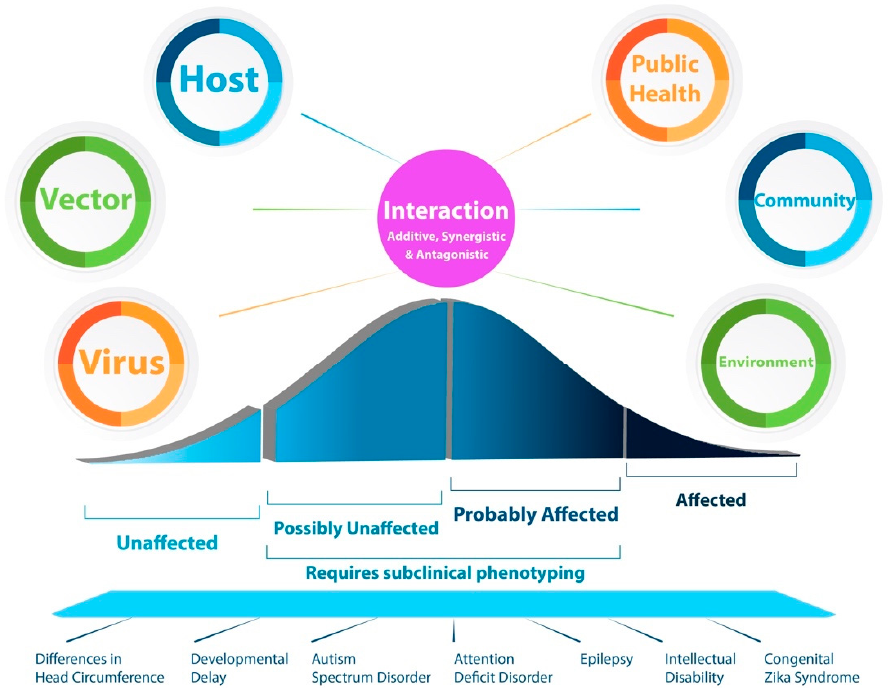
Figure 1. Interaction between possible disease modifiers and the spectrum of outcomes associated with prenatal viral infections. Various factors, including viral, vector, host, medical, community, and environment, may contribute to the spectrum of neurodevelopmental disabilities seen after pre- natal viral infection, including in the case of Zika virus. These, in-turn, may interact in additive, synergistic, or antagonistic ways, which are yet unclear. The resulting phenotypic spectrum in- cludes infants who are unaffected, possibly unaffected, probably affected, or affected. Affected in- dividuals are commonly identified in appropriate clinical care settings, but the majority of individ- uals who are affected will likely require subclinical phenotyping, which can include neuroimaging, serial neurodevelopmental follow-up, and quantitative morphometrics. The resulting end-pheno- types can include a range of neurodevelopmental disabilities, which may include quantitative dif- ferences in head circumference, developmental attainment, the risk for seizures or epilepsy, social skills, attention, and intellect. Importantly, congenital Zika syndrome is but one manifestation of prenatal viral